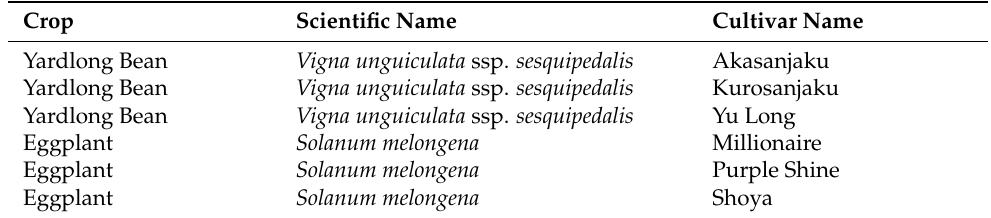
Table 2. List of cultivars of eggplants and yardlong beans used in the field trials in El Paso in west Texas and Overton in east